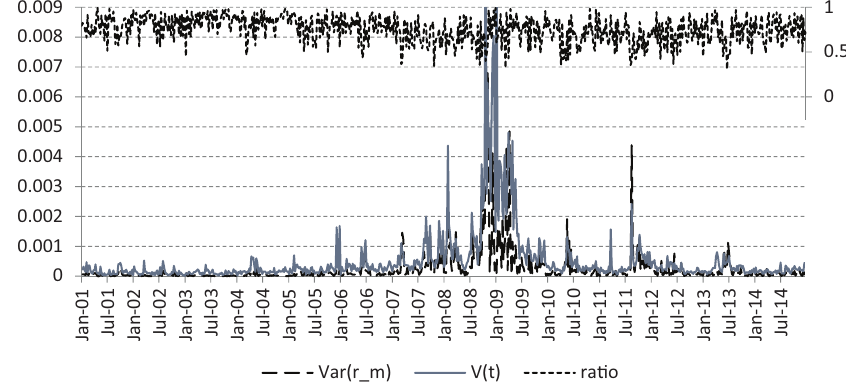
Figure 1. The decomposition of the total variance of Global REITs market into market variance and average firm- specific variance (left y-axis) as well as the ratio of firm-specific risk to total risk (right y-axis) Note : V(t) denotes the average market-specific risk and Var( r _m) denotes the market